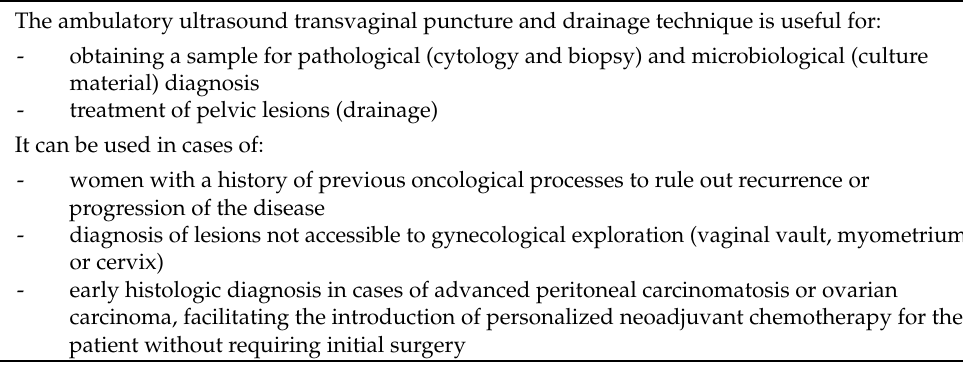
Table 1. Indications for transvaginal echo-guided puncture.